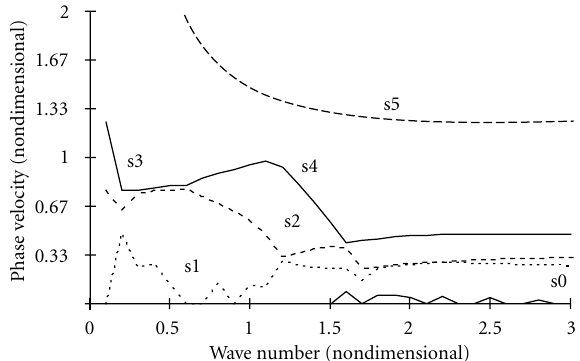
Figure 8.4. Dispersion of the first six extensional modes for τ 0 = 2 . 10 − 7 second and τ 1 = 1 . 10 − 6